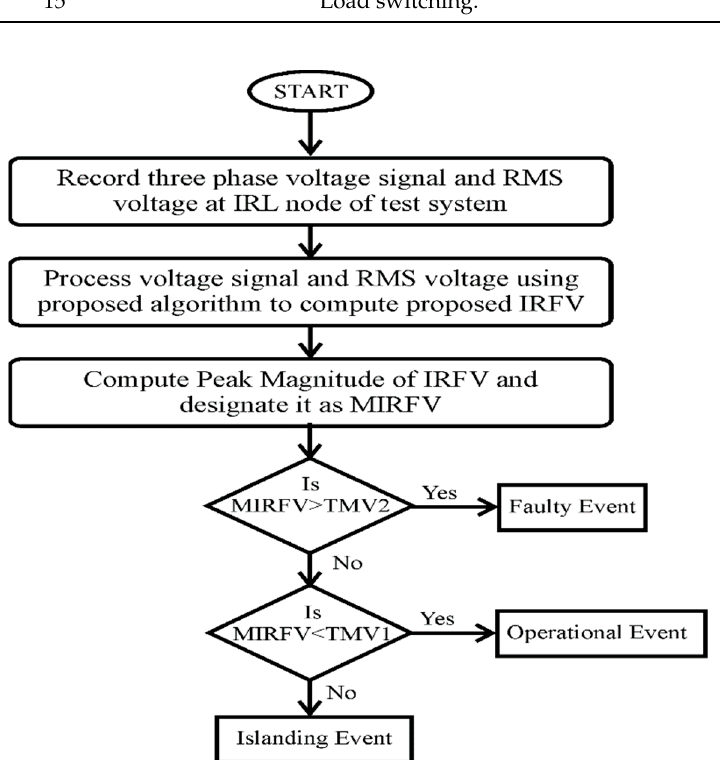
Figure 18. Discrimination of islanding event from the faulty and operational events using voltage- based IRF.